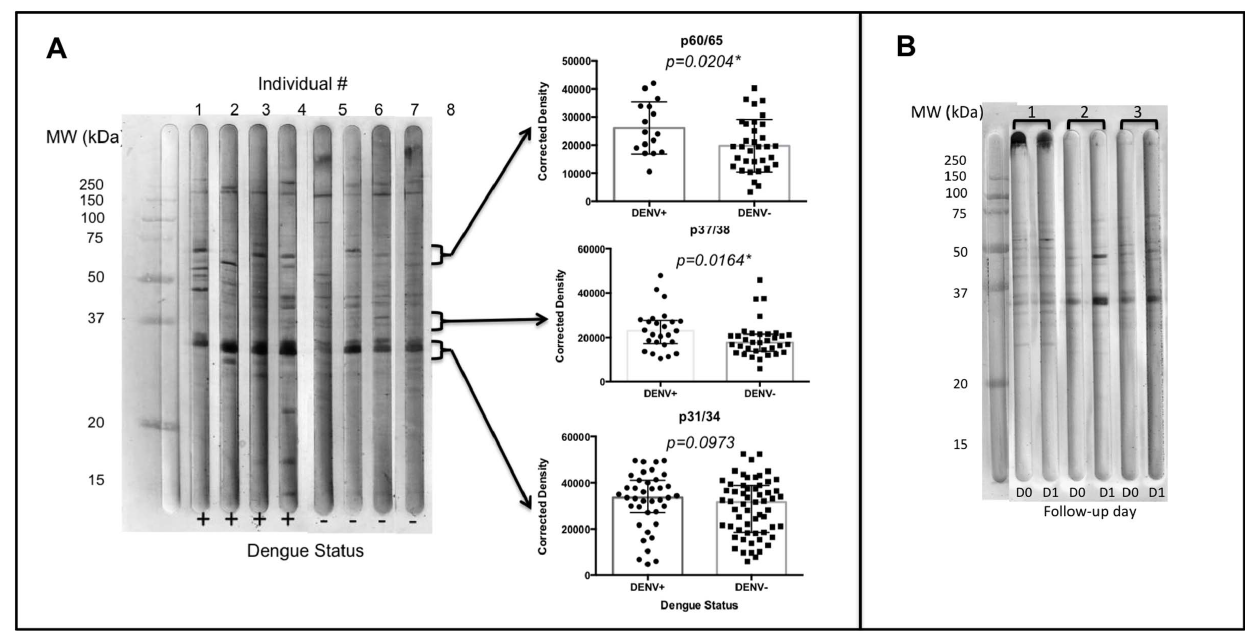
Figure 5. Representative western blot results from four DENV-RNA ( + ) and four DENV-RNA ( 2 ) individuals from Los Patios, with corresponding statistical analysis of 104 (DENV-RNA ( + ) (n=41), DENV-RNA ( 2 ) (n=63)) samples tested. Statistical significance (*) p , 0.05 (A). Western blot results from three non-febrile healthy individuals from Pamplona on day 0 (before travel to endemic area (DO)) and day 1 (after travel (D1)). Numbers represent each subject